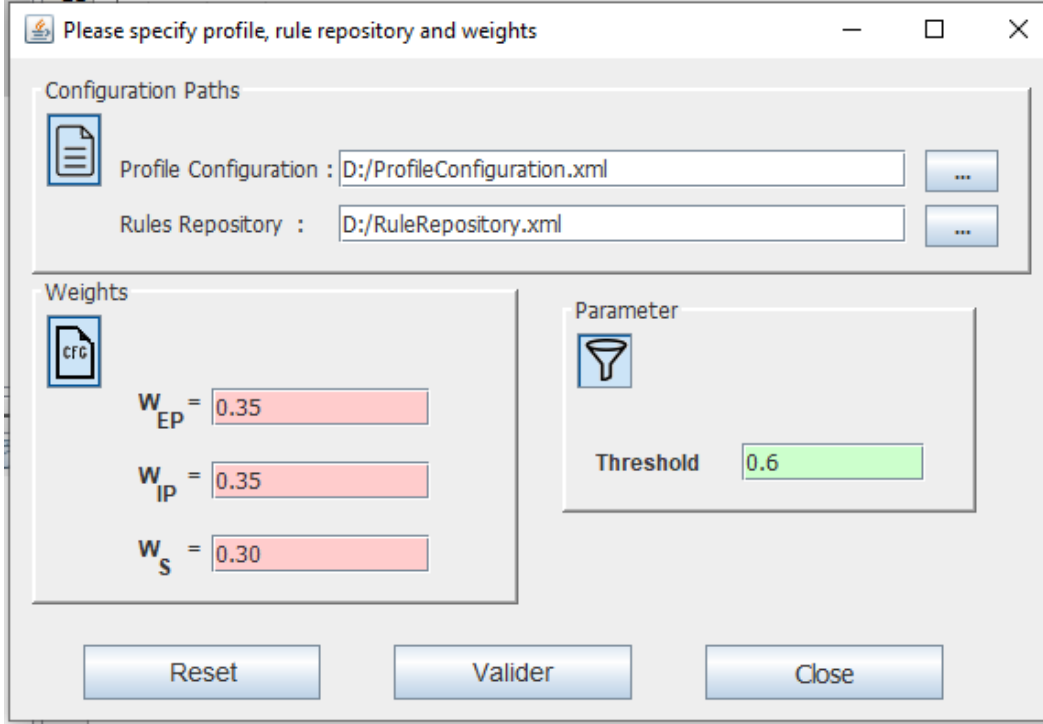
Figure 8. Similarity weights for all scenarios.